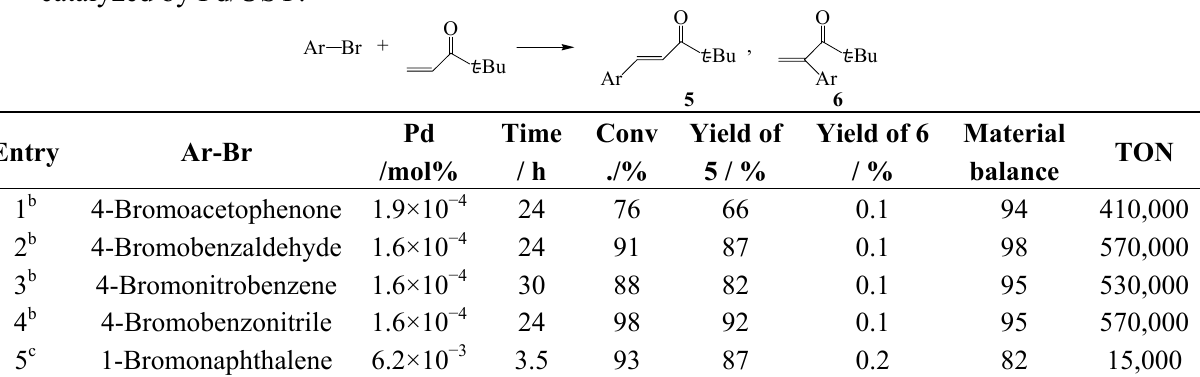
Table 6. Heck reactions between bromobenzene derivatives and tert -butyl acrylate catalyzed by Pd/USY.